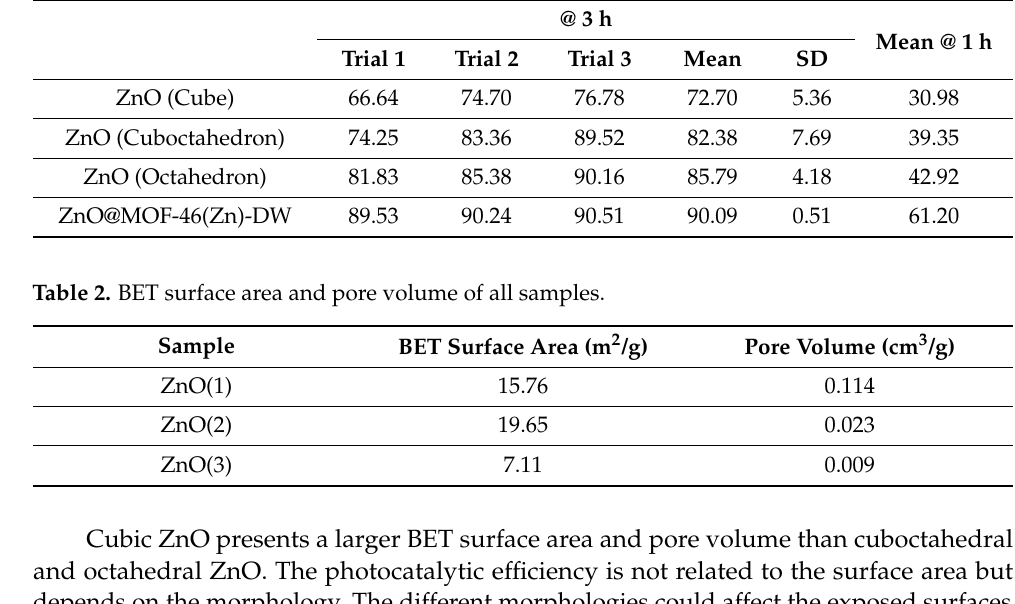
Table 1. Photocatalytic efficiency of all prepared ZnO and ZnO@MOF-46(Zn)-DW.